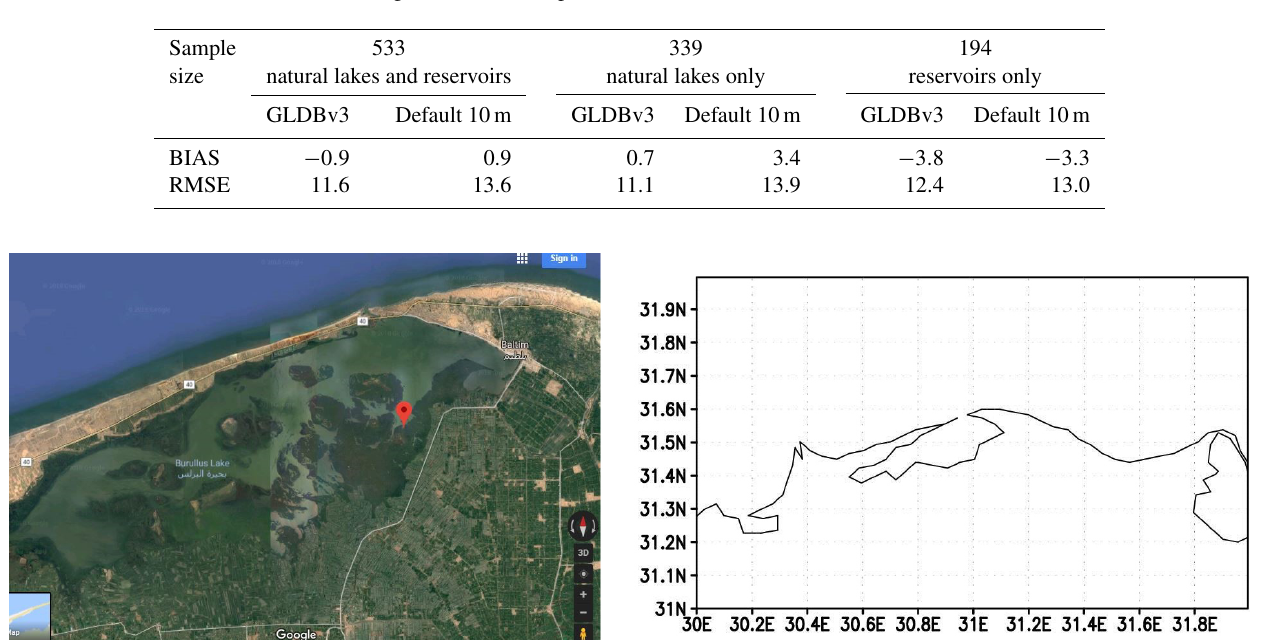
Table 1. Verification of indirect estimates against new lake depth observations.